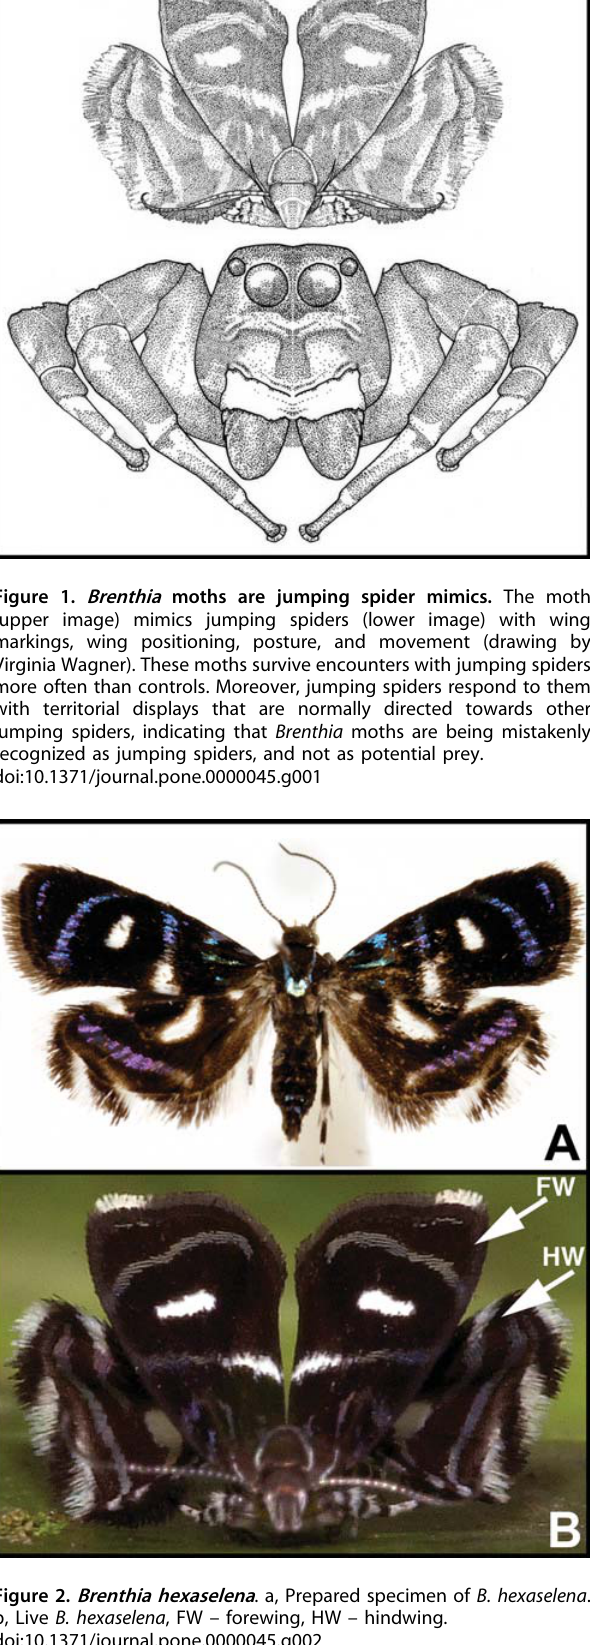
doi:10.1371/journal.pone.0000045.g003